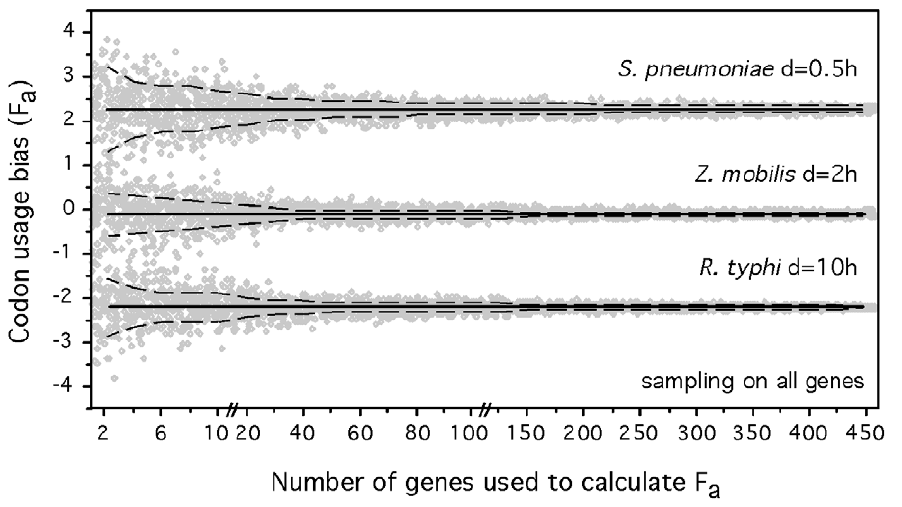
Figure 6. Accuracy of the determination of composite codon usage bias (F a. ) with varying sample size. F a was calculated on randomly chosen samples (from 2 up to 450 genes) of all genes while using the full dataset of highly expressed genes. 100 iterations were effectuated for each sample size. The results for 3 organisms (one fast, slow and intermediate grower) are represented. The full black lines correspond to the whole genome value of F and the dashed lines to the standard deviations. Each data point is represented in gray.